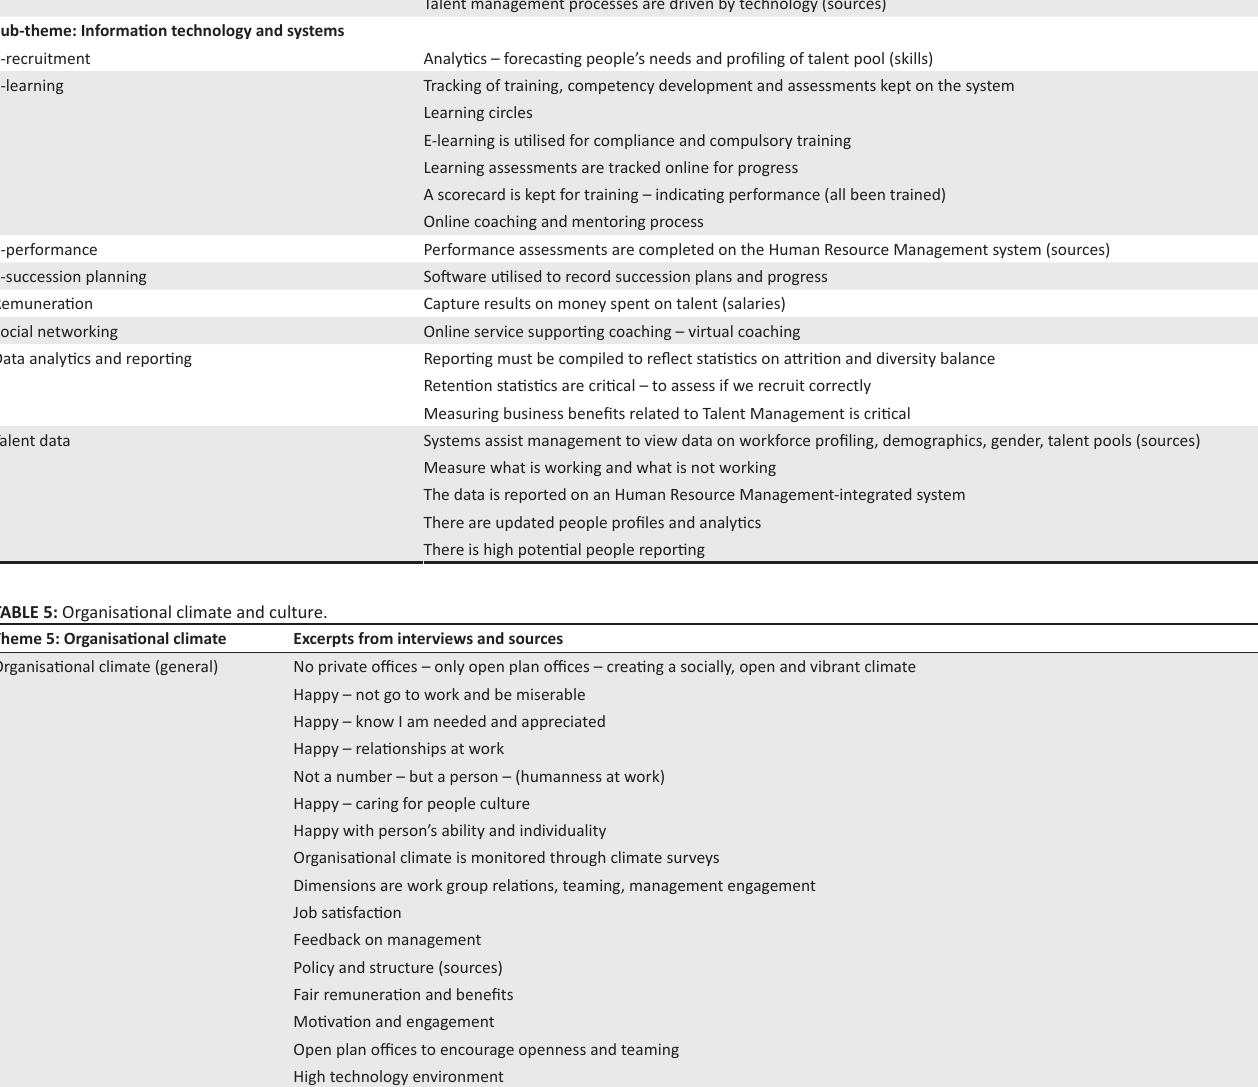
TABLE 4: Information technology and systems.